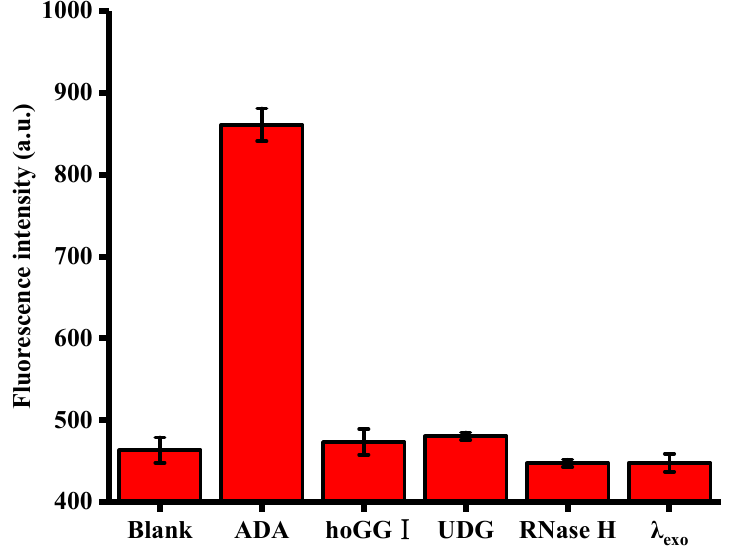
Figure 5. Relative fluorescence intensity of the reaction systems upon addition of ADA, hoGG I, UDG, RNase H and λ exo. Error bars were estimated from three replicate measurements.